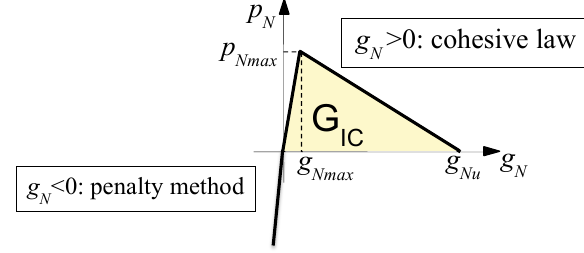
Figure 4: Relationship between interfacial tractions and relative displacements in the normal direction.